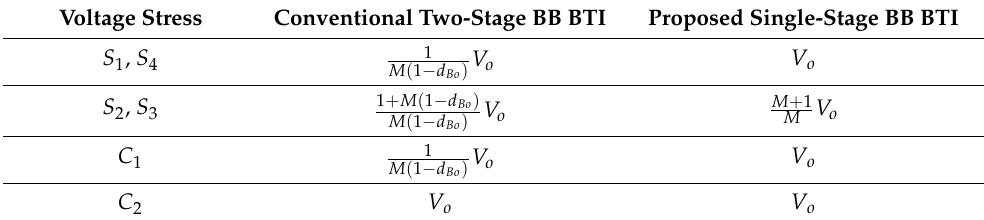
Table 1. Comparison of conventional two-stage BB-BTI with the proposed single-stage BB BTI.